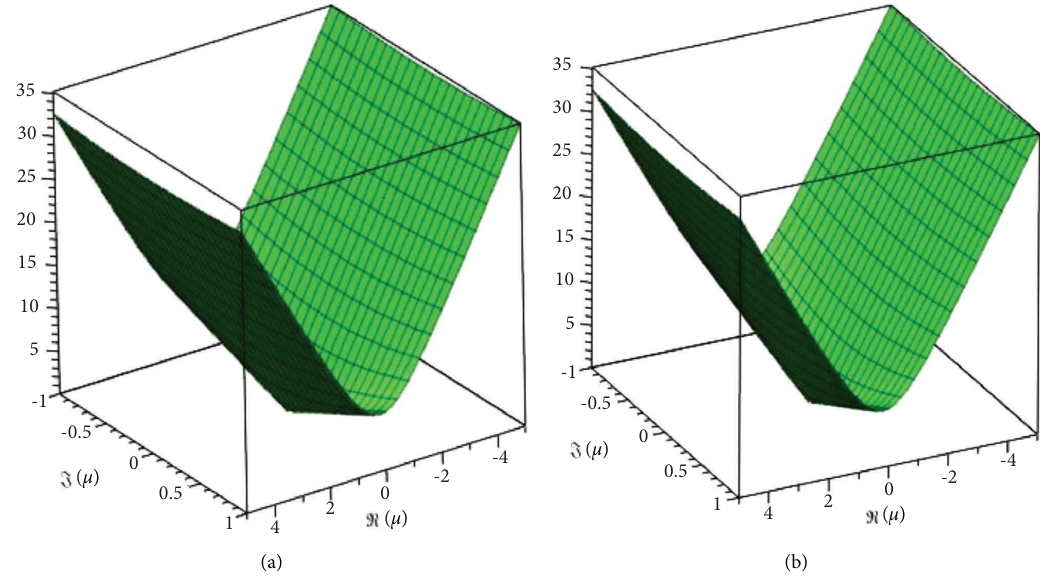
Figure 8: For varying Z and η values, the detected cases are increasing fastly from day-to-day (a) E